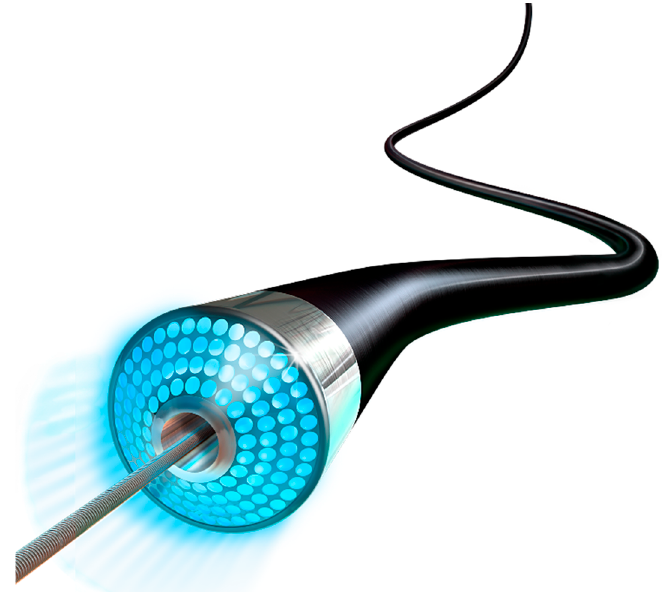
Figure 8. Turbo-Elite Laser Atherectomy System. Courtesy of Philips